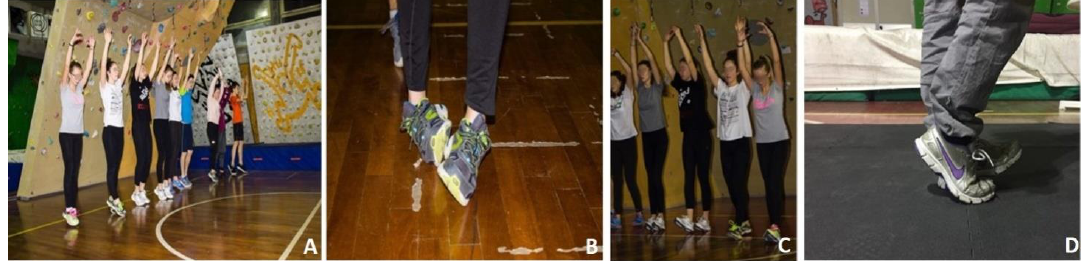
Figure 7. Squat position for mobilization of the coxo–femoral joint.